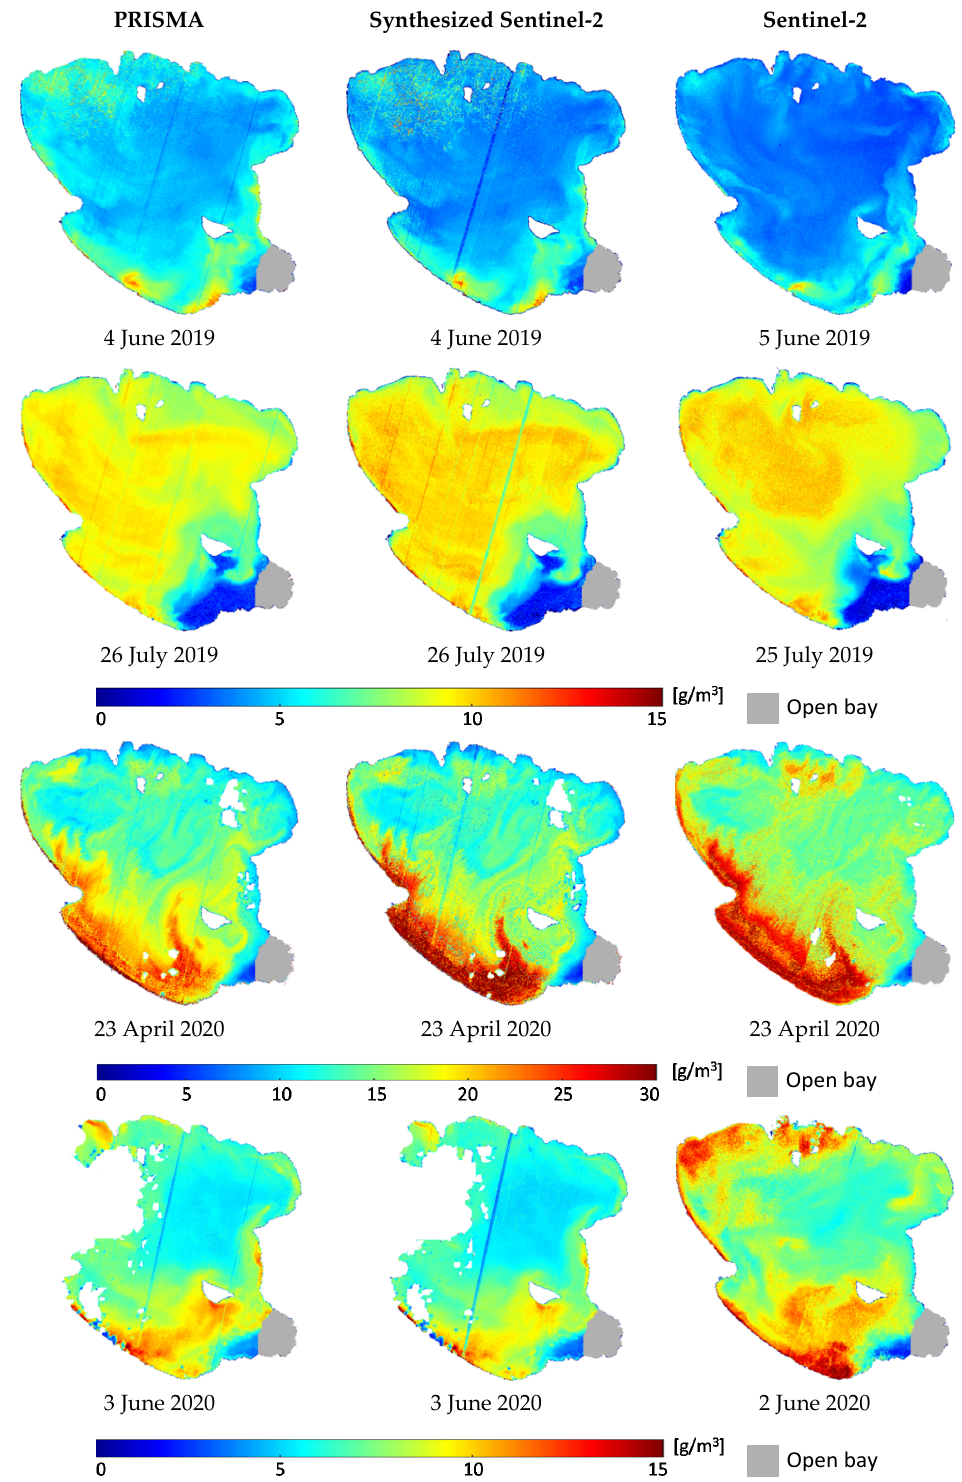
Figure 6. Multitemporal total suspended matter (TSM) maps derived from PRISMA, synthesized Sentinel-2 (PRISMA resampled), and Sentinel-2 images. The missing data are related to the cloud cover.